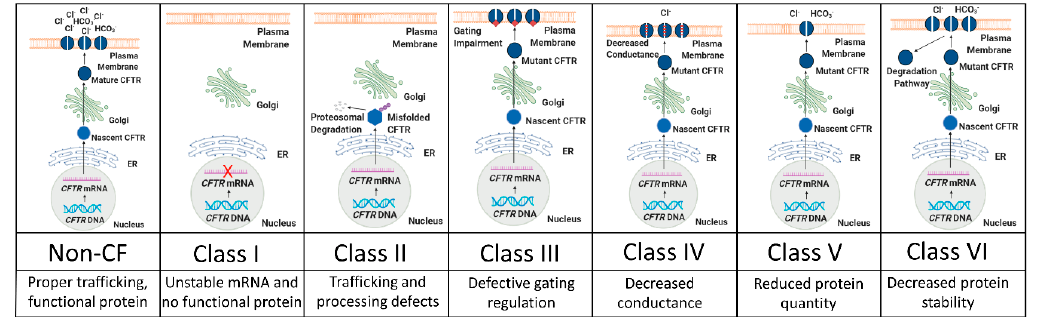
Figure 1. Schematic representation of CFTR (CF transmembrane conductance regulator) mutation classes. The top panels briefly illustrate CFTR trafficking along its proteostasis pathway and how protein maturation is disrupted by mutations. The middle panels list the mutation class, while the bottom panels briefly describe the defect(s) associated with each class. Adapted from [28].